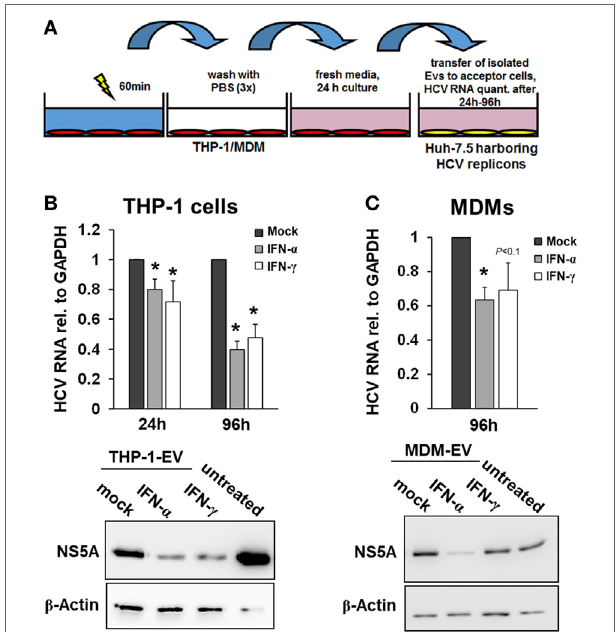
FigUre 3 | Macrophage-derived extracellular vesicles (EVs) inhibit hepatitis C virus (HCV) replication. (a) Schematic outline of EV transfer experiments. Macrophages were treated with mock, IFN- α (500 IU/ml), or IFN- γ (25 ng/ml) for 24 h. EVs were isolated from conditioned supernatants of macrophages using differential centrifugation. EVs containing 100 µg of protein were transferred to Huh-7.5 hepatoma cells harboring subgenomic HCV replicons. (B,c) EVs from IFN-pulsed THP-1 cells (B) and MDMs (c) inhibit HCV replication. HCV mRNA levels (upper panel) were quantified by Taqman real-time PCR 24 or 96 h after transfer of EVs. Mean and SEM of three independent experiments are shown. Western blot analyses of HCV NS5A protein levels after exposure to THP-1 or MDM supernatants for 96 h (lower panel) (* P <